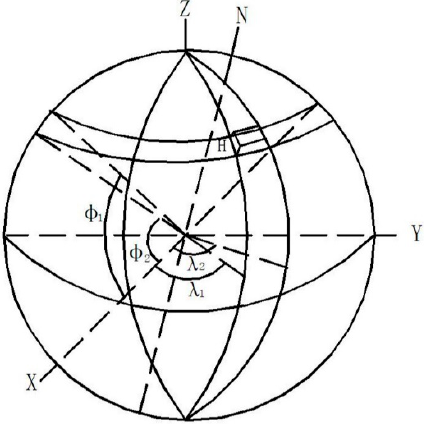
Figure 3. Schematic diagram of the sphere theory model.